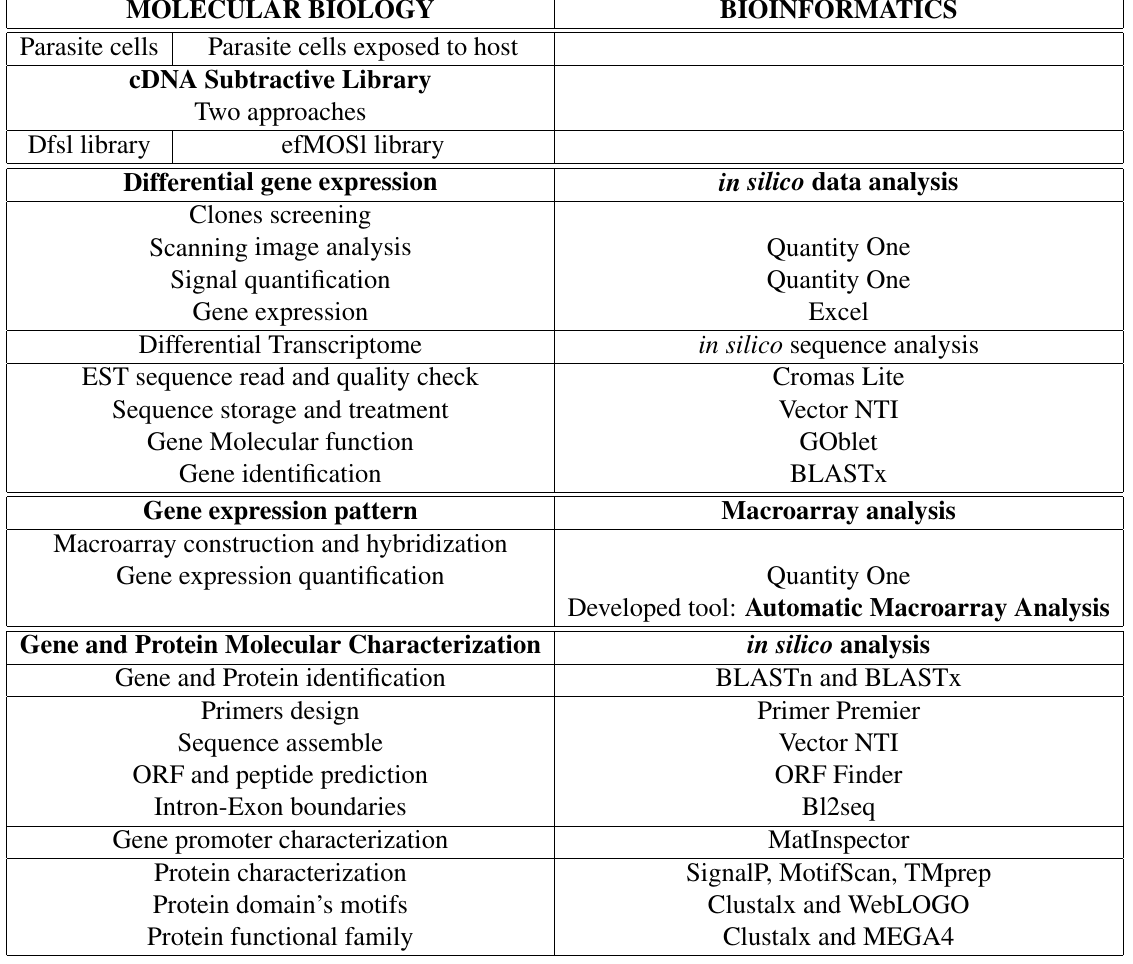
Table 1: Work-flow followed for P. olseni transcriptome and molecular characterization, showing the Molecular Biology strategy aside with Bioinformatic tools